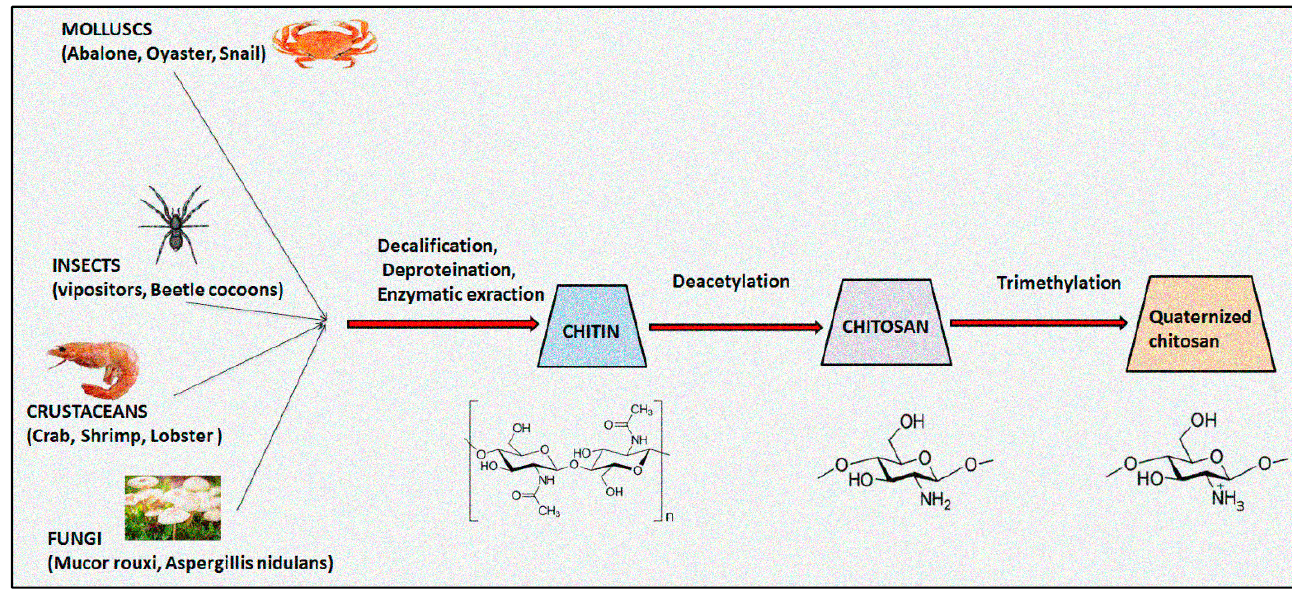
Figure 1. Schematic developmental process of quaternized chitosan from native chitin. Conformational changes in the chitosan skeleton are reliant on local environmental conditions including the pH, pKa, N-substitution group, process temperature and types of acids. The functional groups (hydroxyl and amino) contribute an essential role for imparting solubility to the chitosan molecule. At low pH, the attached amino group undergoes protonation, solubilizes and provides positive charge to the medium, offering strong electrostatic interaction with negative charge cell components. Moreover, the pKa of amino group highly depends on the degree of acetylation (DA); hence, the solubility of chitosan is also reliant on DA [11].